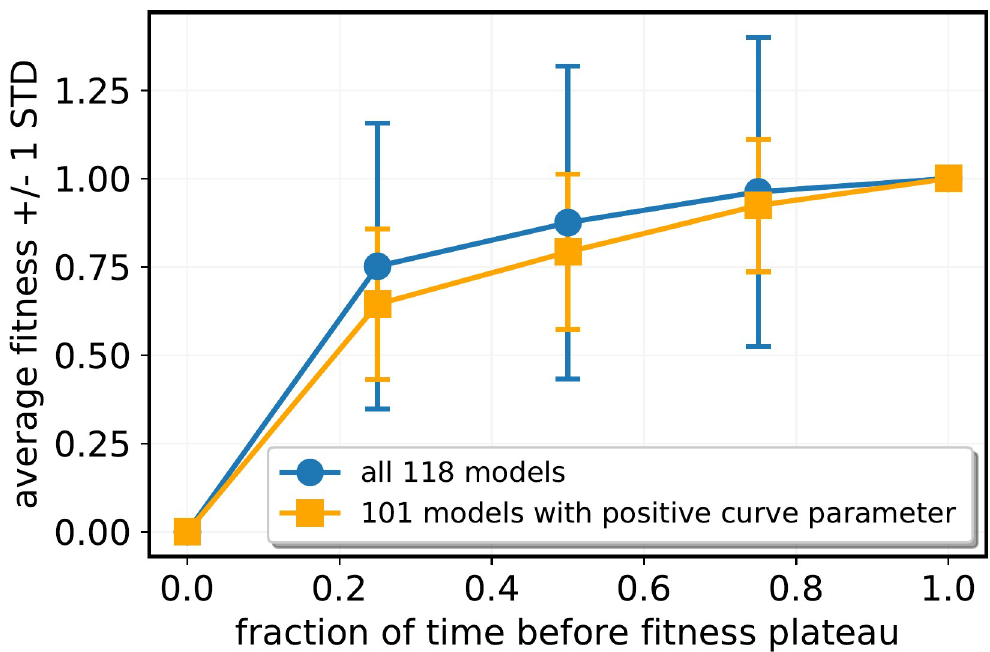
Fig 5. Average fitness of the model runs. Curves are normalized to maximum fitness = 1. The X axis shows the fraction of time until the fitness reaches a stable plateau. The average fitness across all 118 model runs was calculated for time = 0, time = between 0.25 and 0.5, time = 0.5–0.75, time = 0.75–1 and time > 1 (i.e. on the plateau of fitness). By definition, fitness = 1 when time > 1. Error bars are standard deviation. Blue curve: All 118 model runs. Orange curve: 101 model runs for which Curve Parameter C p >